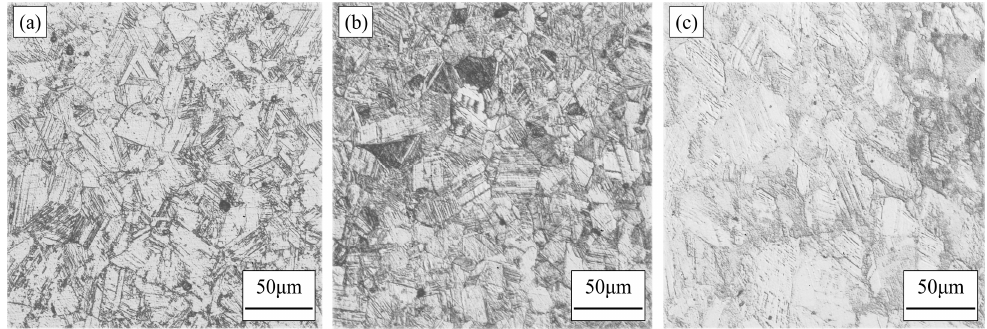
. ε = . ε = . ε = 0.5 s − 1 ; ( b ) 0.05 s − 1 ; ( c ) 0.005 s − 1 . Metals 2019 , 9 , x FOR PEER REVIEW